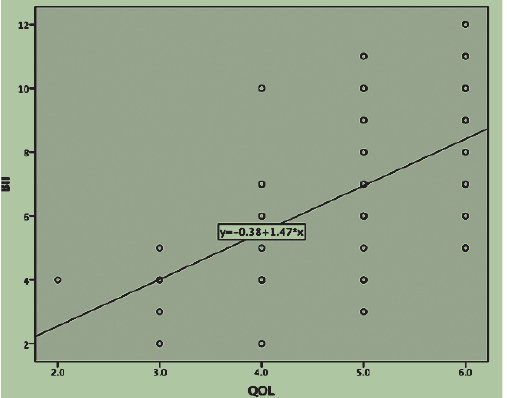
Figure 3. Scatter diagram showing correlation between QOL and BPH II